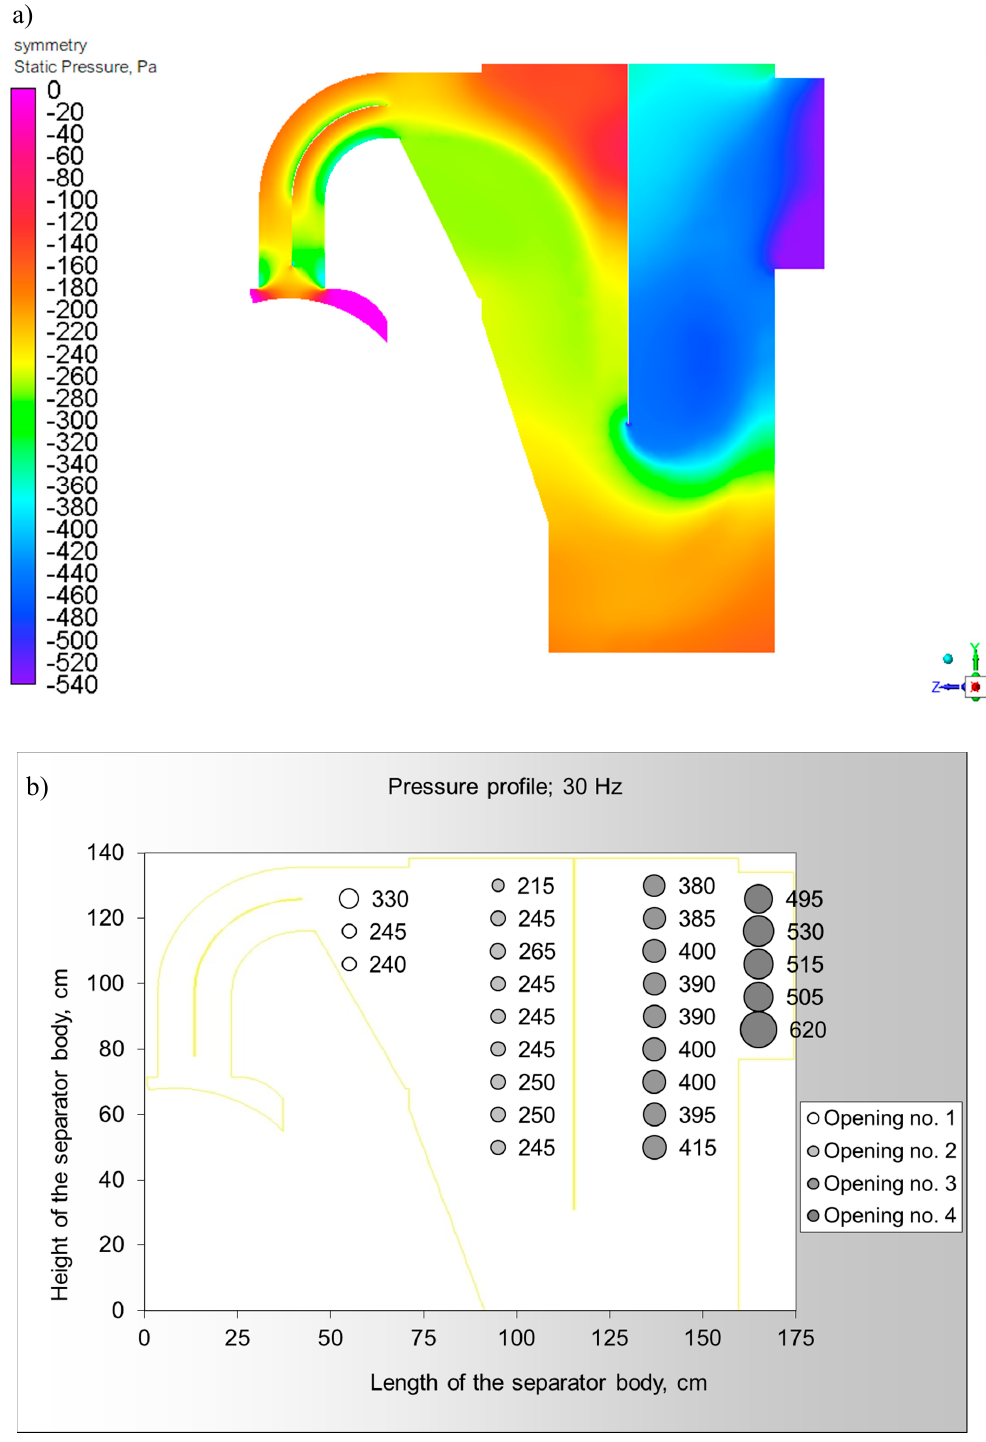
Figure A12. Pressure profile in the sorter symmetry plane (simulation of the main fan at 30 Hz): ( a ) numerical model (gauge pressure) and ( b ) measured (negative pressure).